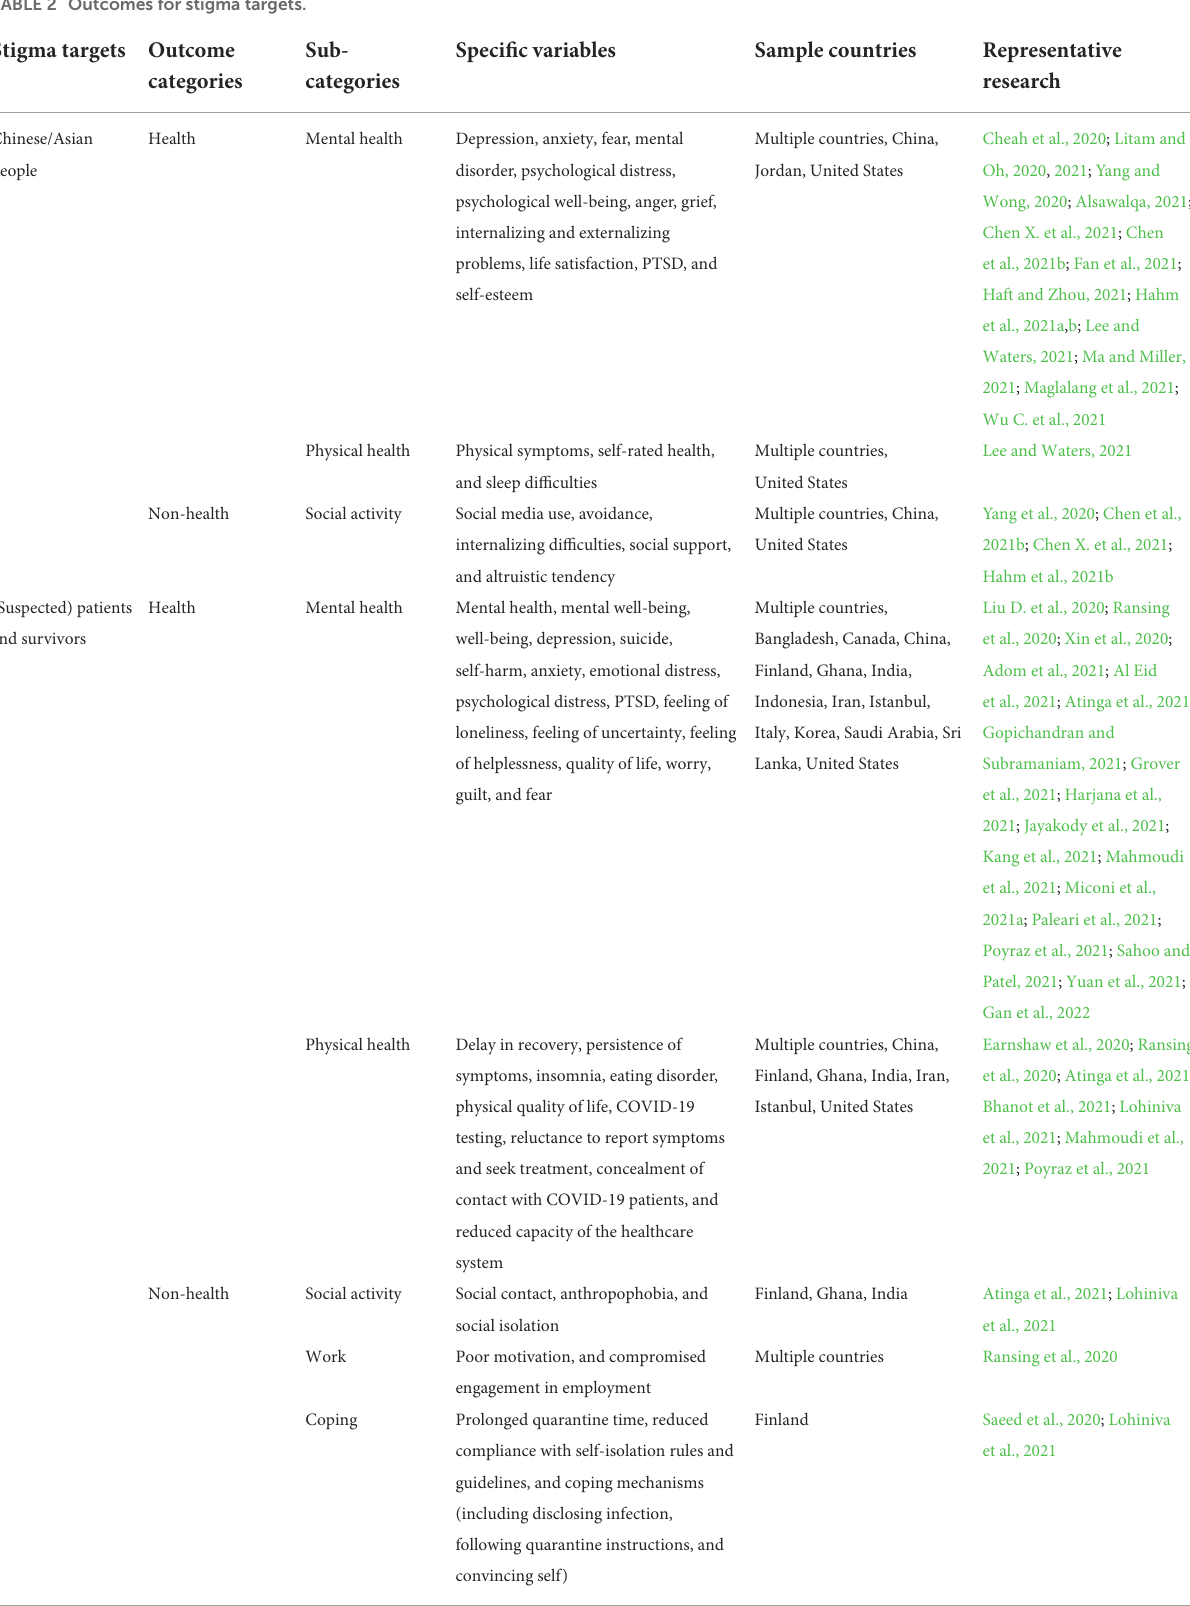
TABLE 2 Outcomes for stigma